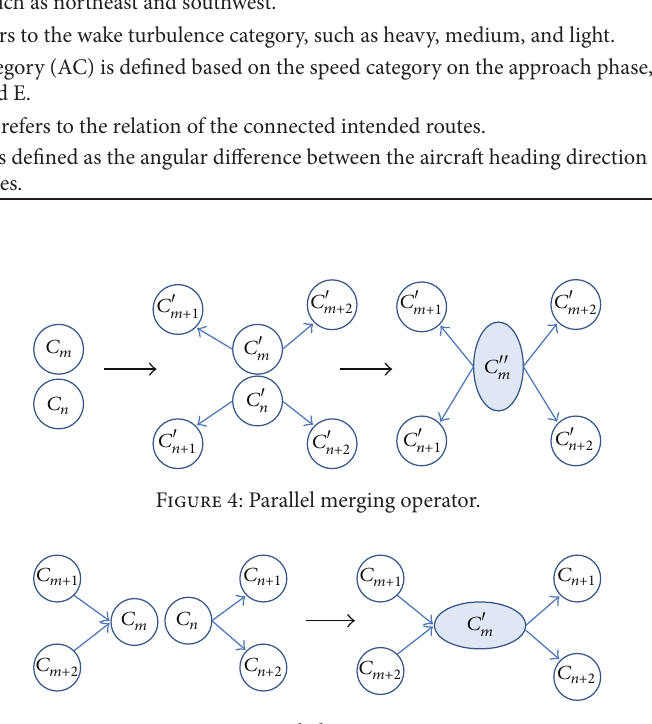
Figure 5: Cascaded merging